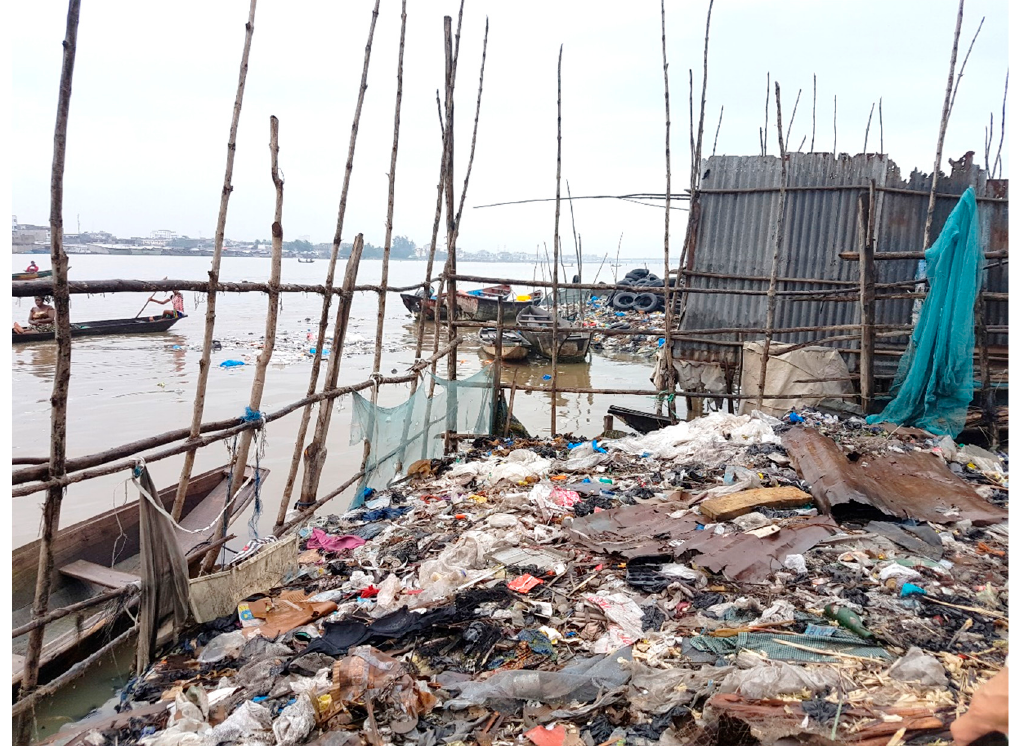
Figure 2. Waste infill in a river serving as foundation bed for an incoming slum housing.